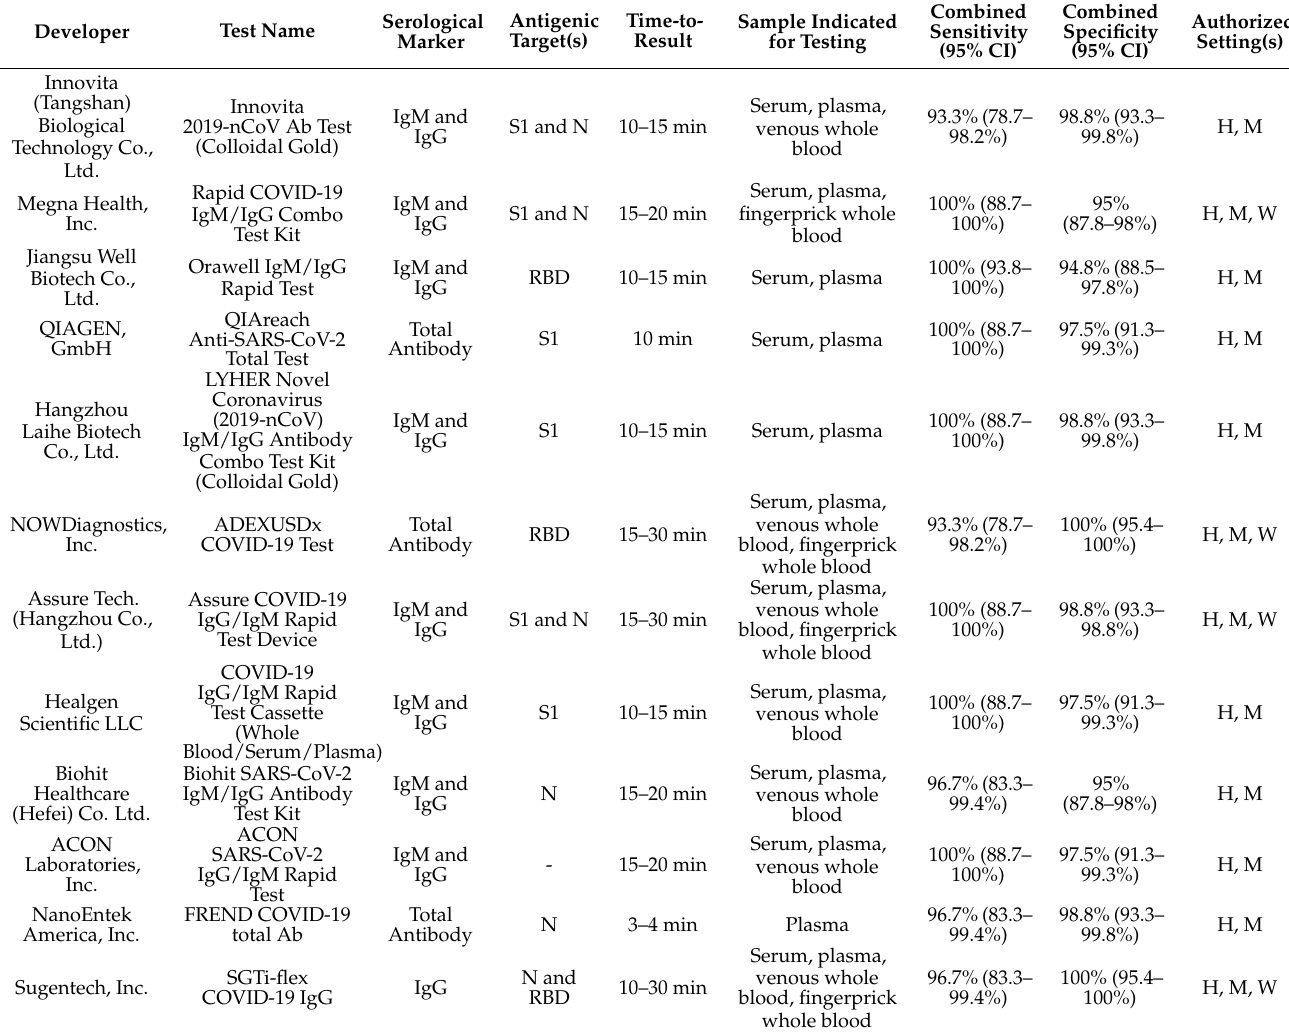
Table 3. Characteristics of FDA-EUA serological LFIs for the detection of antibodies against